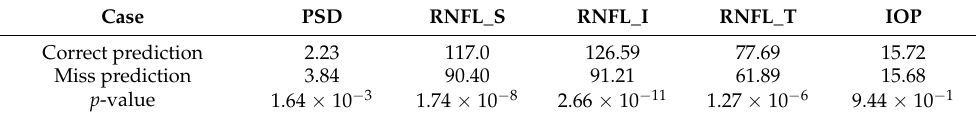
Table 9. Analysis of prediction: healthy